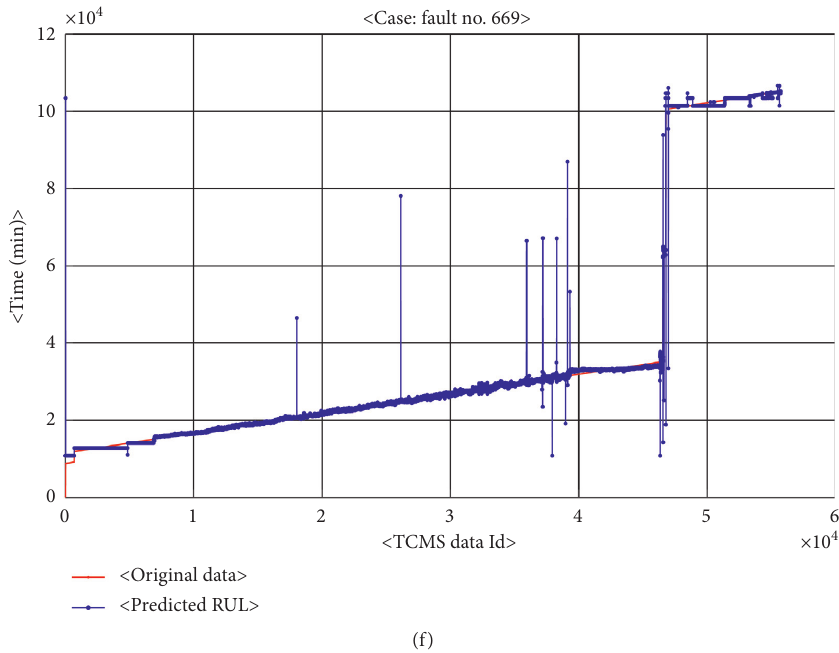
Figure 9: RUL prediction results using the proposed method. (a) Fault code ID 34 (LIU2 communication error in TC0). (b) Fault code ID 231 (SIV inverter malfunction). (c) Fault code ID 434 (break malfunction). (d) Fault code ID 635 (TC MFB malfunction). (e) Fault code ID 640 (main ATC hardware malfunction LIU2). (f) Fault code ID 669 (ATO-ATC communication error). Table 10: Test accuracy for each defect using the proposed framework. Fault code